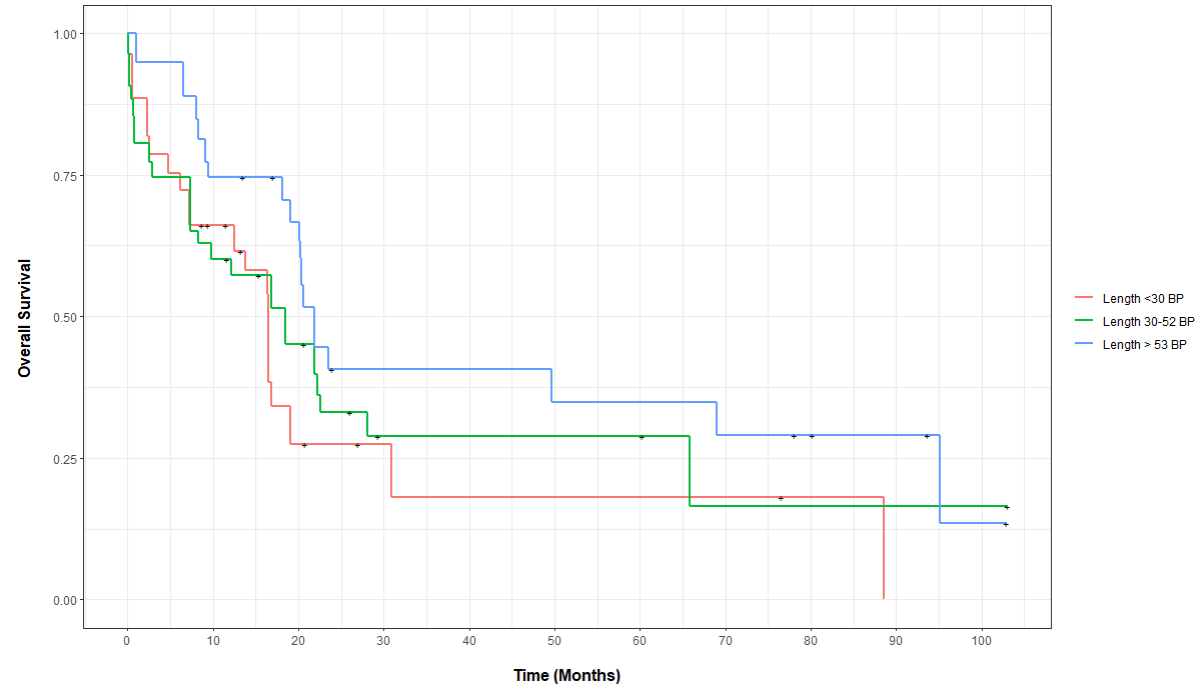
Figure 1. Propensity score ‐ adjusted overall for patients with FLT3 ‐ ITD ‐ mutated AML, categorized by insertion length.